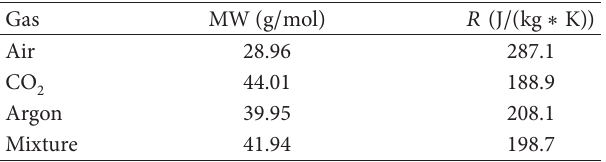
, Argon and the Run 13 mixture. 2 T 3: Gas constants of air, the �uid mixture, and its